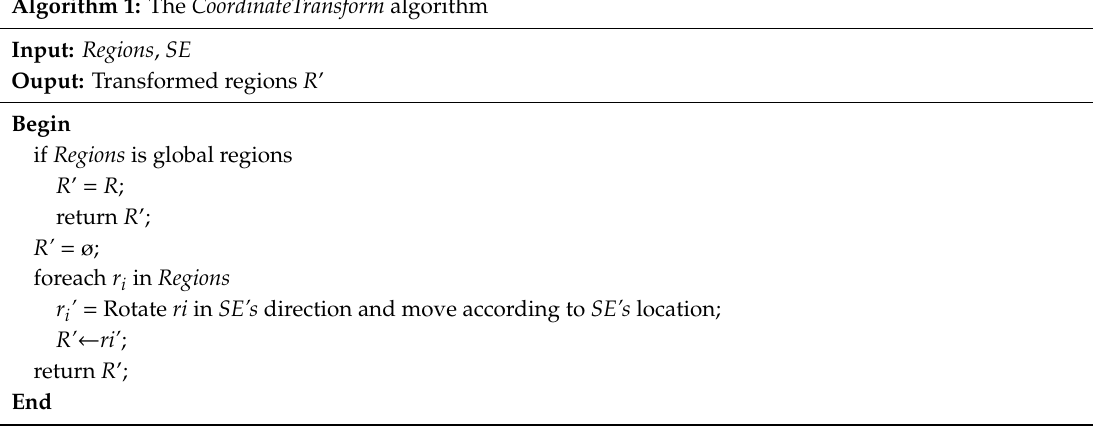
Algorithm 1: The CoordinateTransform